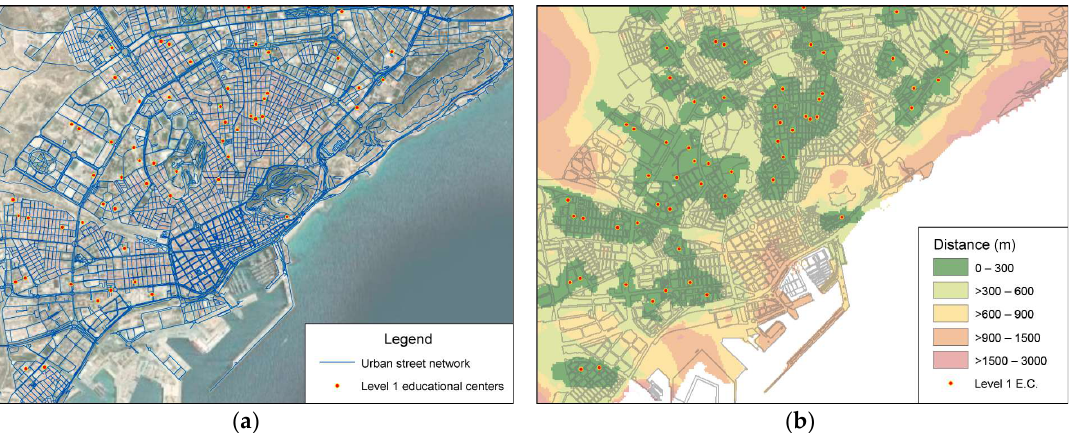
Figure 4. Maps of the city of Alicante. ( a ) Urban street network and level 1 educational centers (infant and primary); ( b ) map of distances (service areas) to level 1 educational centers (infant and primary) obtained by IDW.